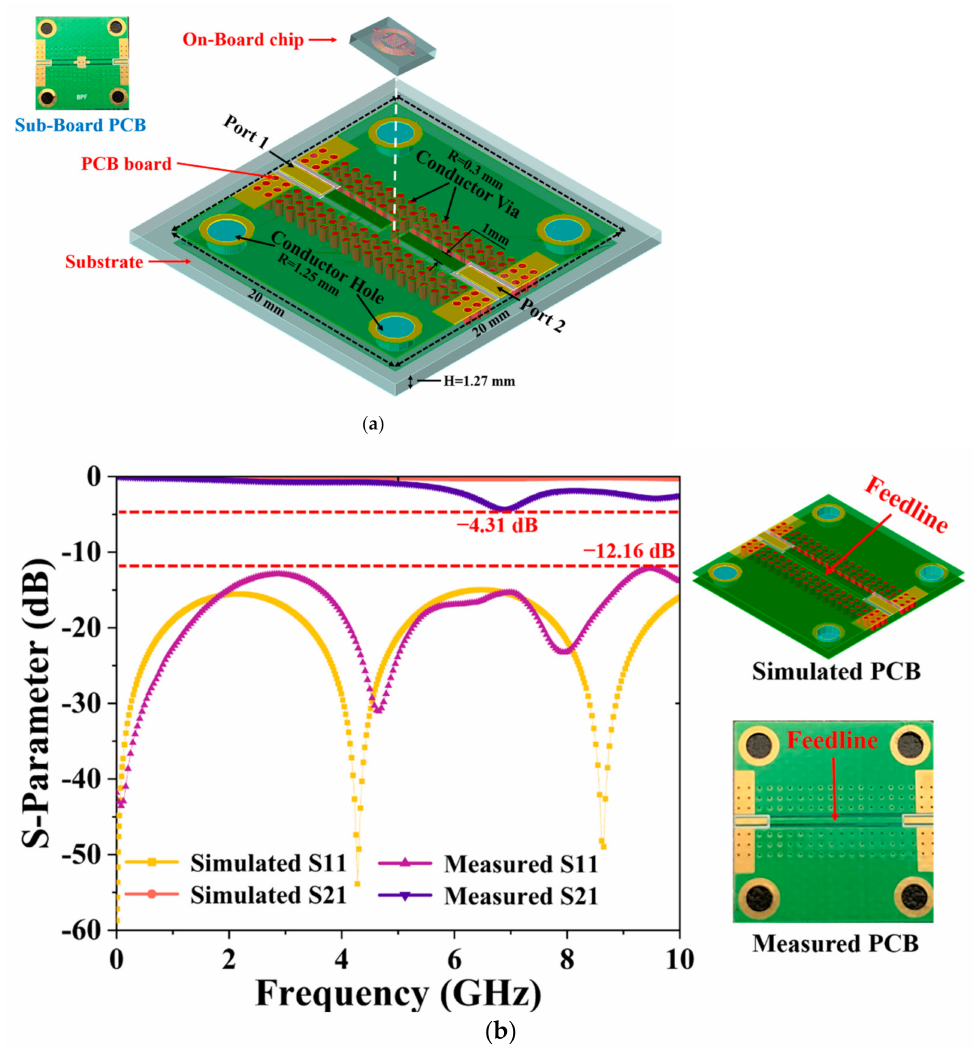
Figure 8. ( a ) Three-dimensional structure of PCB artwork with on-board chip. ( b ) Simulated and measured S-parameter of the PCB with connected